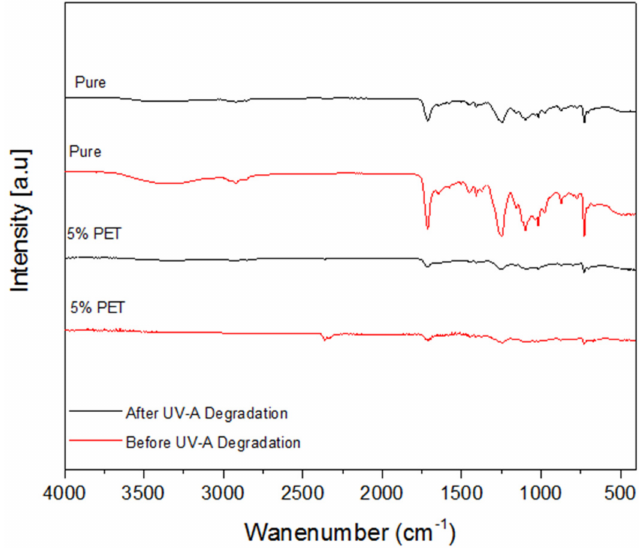
Figure 10. Infrared Spectroscopy of samples containing pure resin and 5% PET fibers before and after degradation